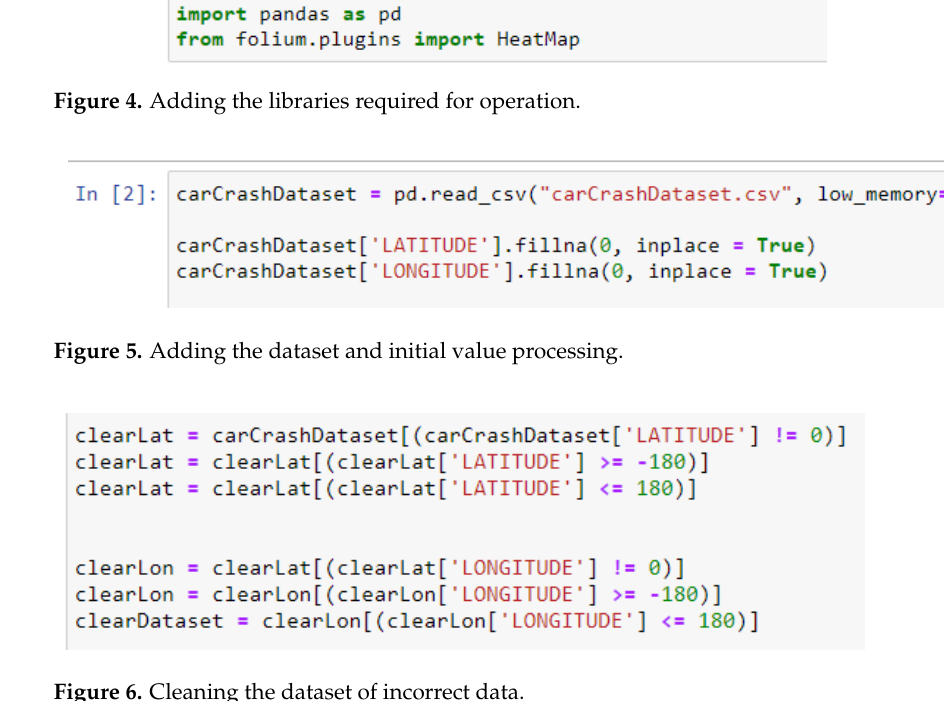
Figure 3. Running the Jupyter environment to work with the dataset.